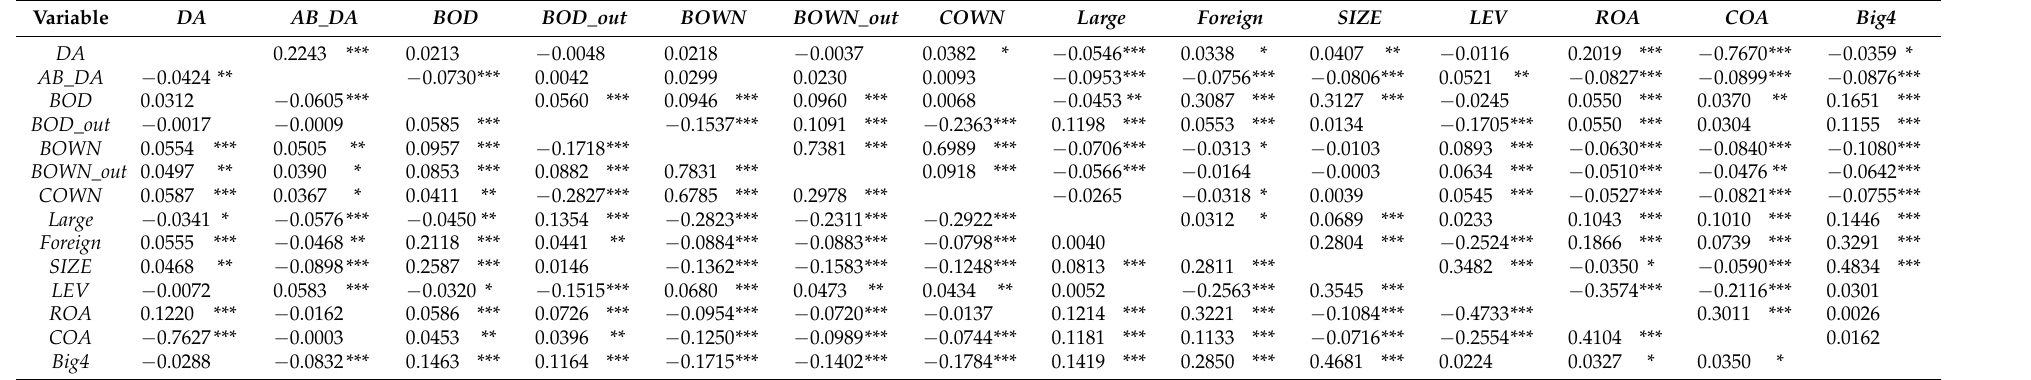
Table 2. The Pearson and Spearman correlation